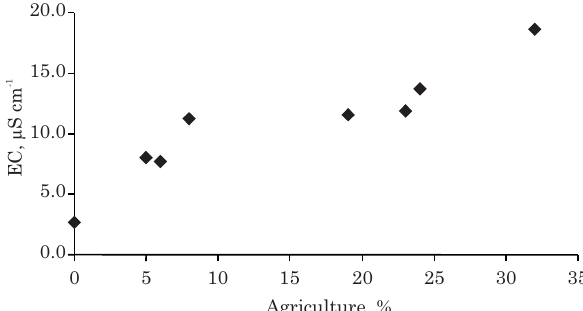
Figure 7. Relationship between agriculture and annual average concentration of electrical conductivity (EC) in the Campestre catchment.